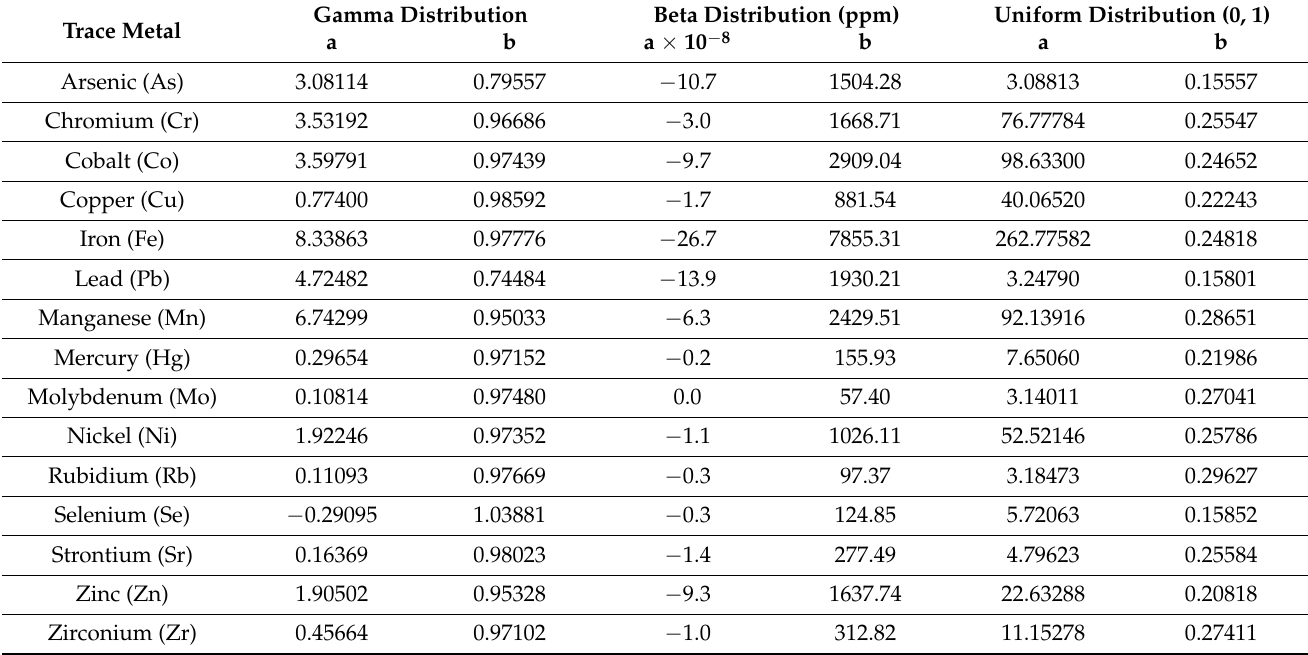
Table A4. Bivariate regression coefficients for response variable y and covariate ˆy (predicted with the quantile covariate) from Table